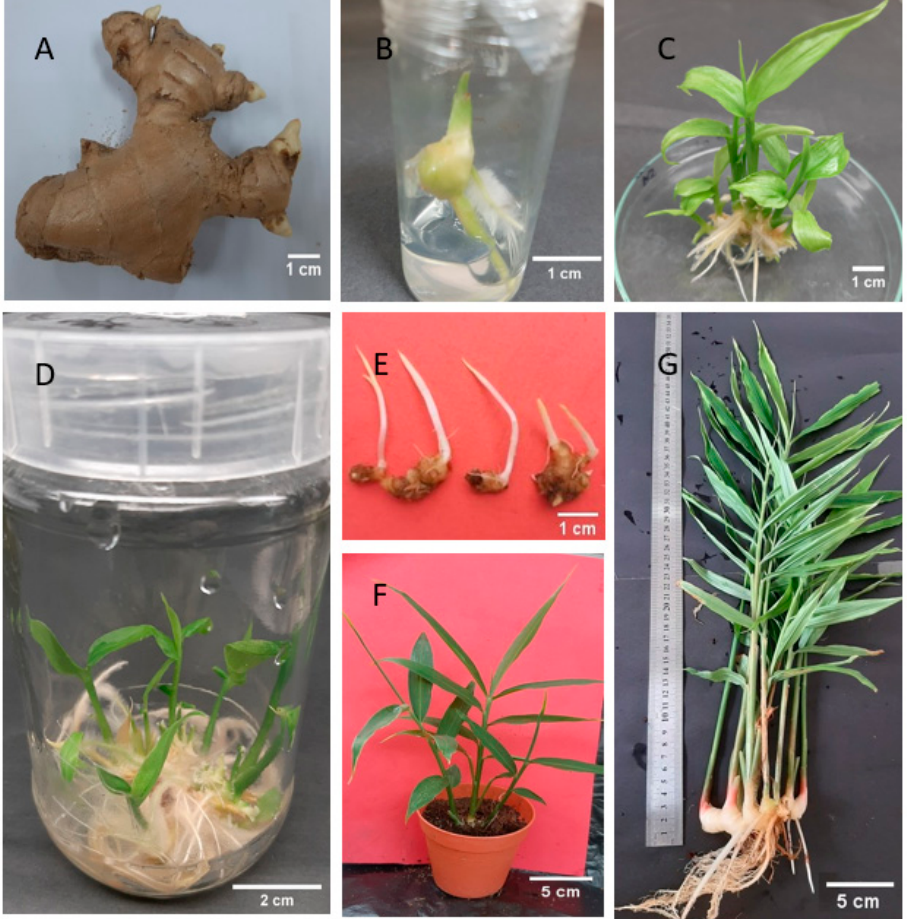
Figure 1. Different stages of Bentong ginger microrhizome induction from culture initiation until ex vitro establishment. ( A ) Mature rhizome with sprouted buds as a source of explants, ( B ) initiated culture from rhizome sprouted bud of Bentong ginger after four weeks of inoculation, ( C ) in vitro- raised shoots of Bentong ginger obtained from MS medium supplemented with 30 g L − 1 sucrose, 10 µM zeatin and 2.5 µM NAA, and these shoots were used as explant for microrhizome induction, ( D ) in vitro-induced microrhizomes with multiple shoots and a bunch of roots after 12 weeks of inoculation, ( E ) microrhizome sprouted in moist sand after two weeks of sowing, ( F ) Bentong ginger plant raised from sprouted microrhizome after one month of growing, and ( E ) Bentong ginger plant with young rhizomes harvested from polybag three months after transplanting.